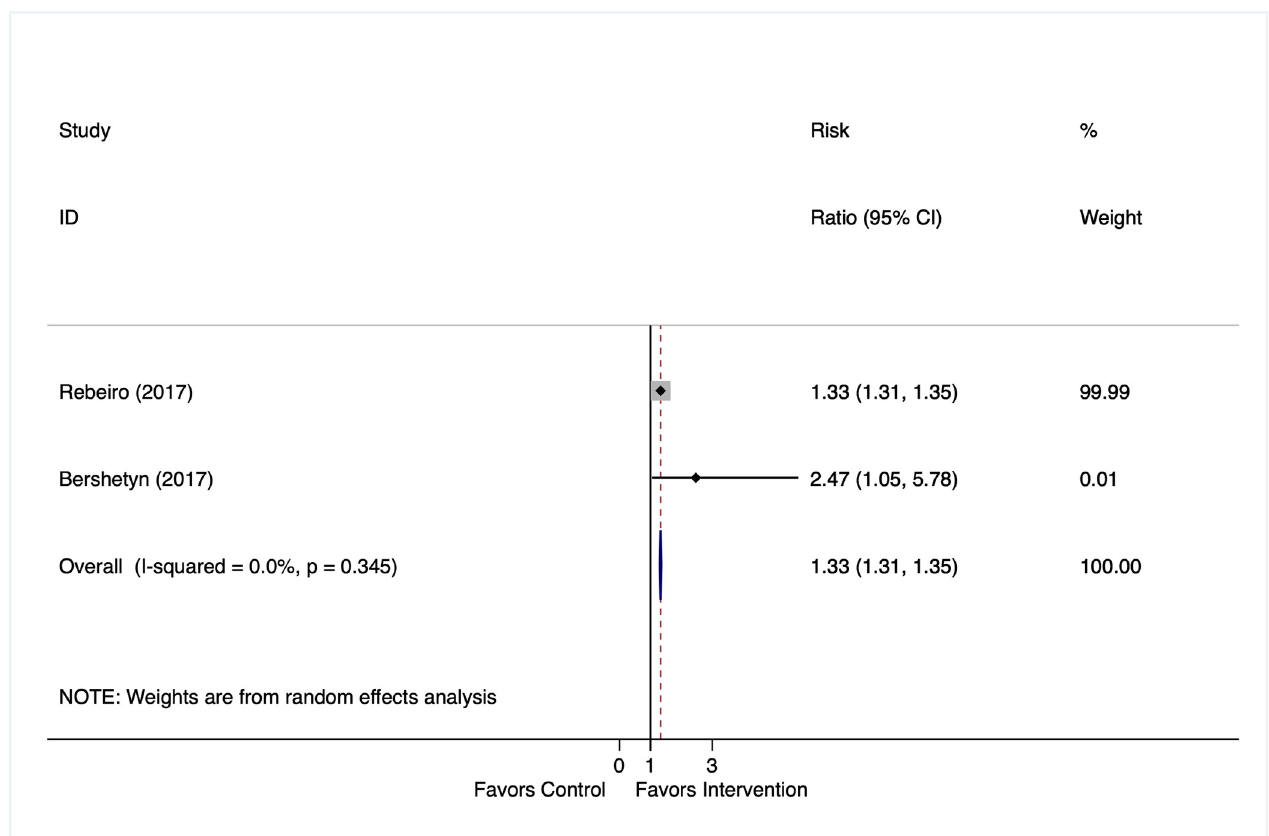
Fig 7. Reengagement contact effects: proportion returned to care among patients who were contacted and found out of care in comparative studies.